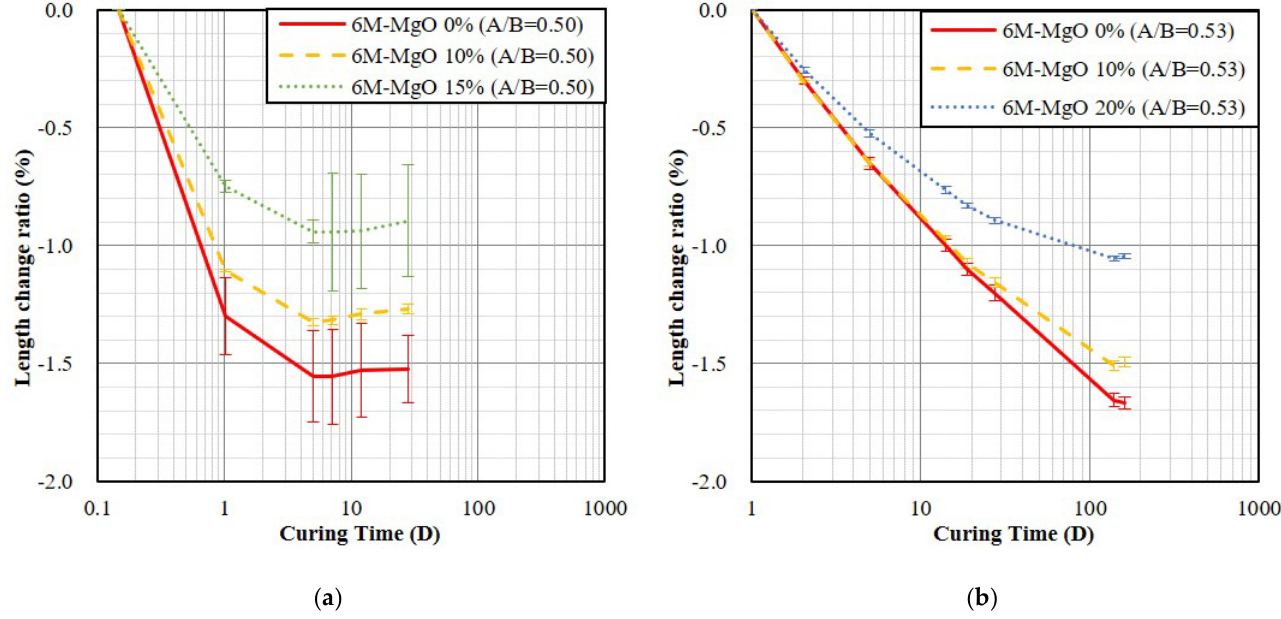
Figure 4. The length change ratios of the GP specimens (fixed A/B). ( a ) 3 h unmolding and A/B is 0.50 (room-temperature); ( b ) 24 h unmolding and A/B is 0.53 (air-dry).